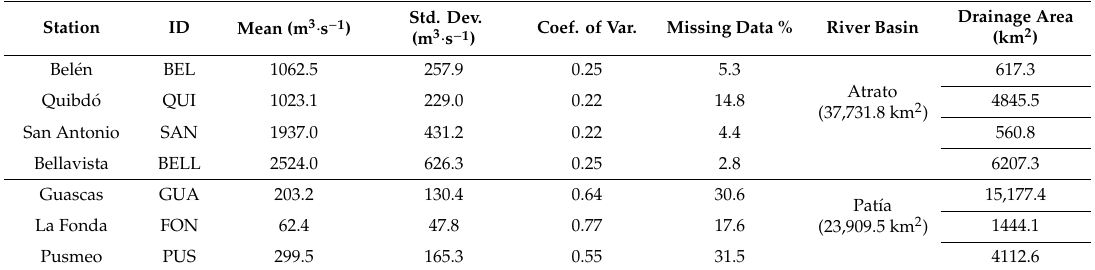
Table 1. Description of the flow gauge stations and discharges used in the